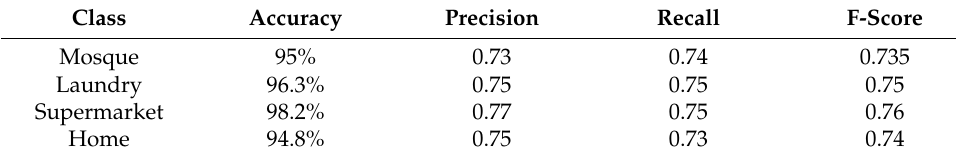
Table 4. Accuracy, precision, recall, and F-score for voice commands.